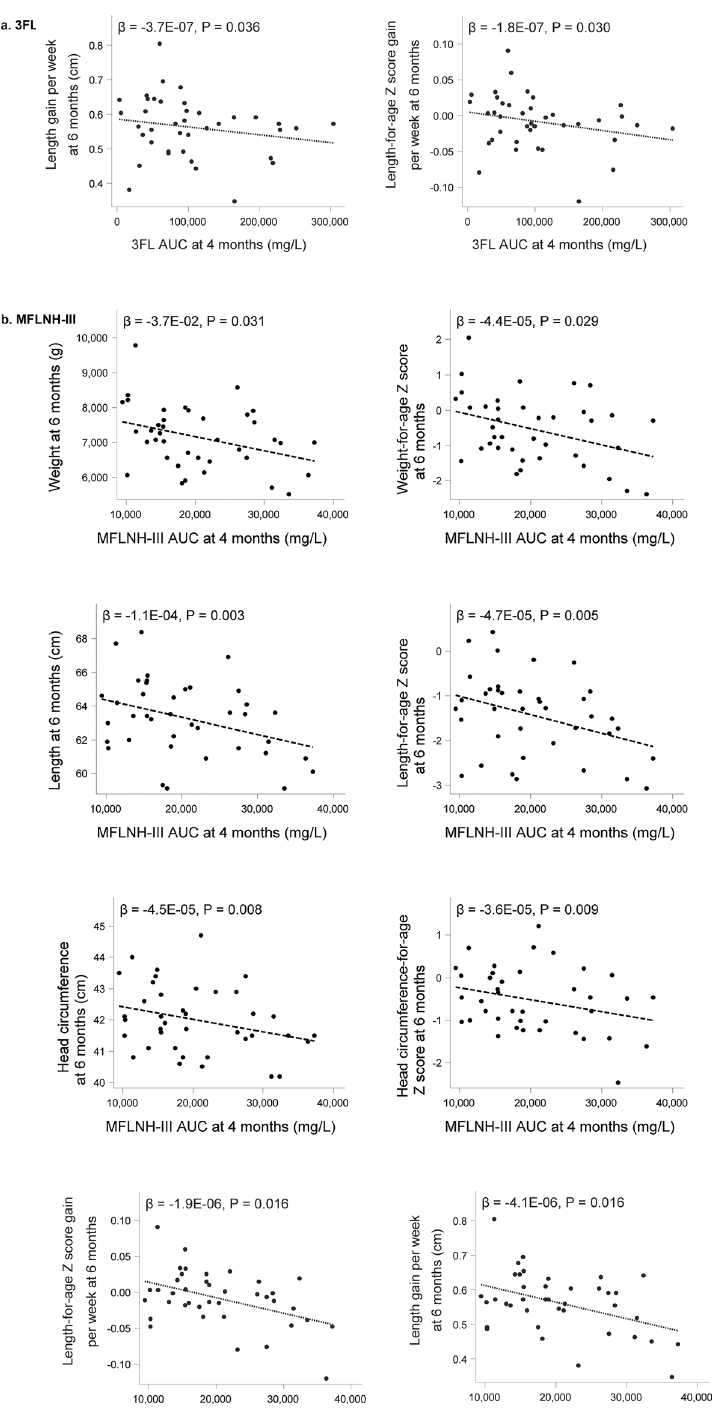
Figure 4. Scatterplots for select HMO Area Under the Curve (AUC) until 4 months of lactation and length gain from birth to 6 months of age ( a ) and weight, length, head circumference and length gain at 6 months and length gain from birth to 6 months of age ( b ) (N = 41). 3FL, 3-fucosyllactose; MFLNH-III, monofucosyllacto-N-